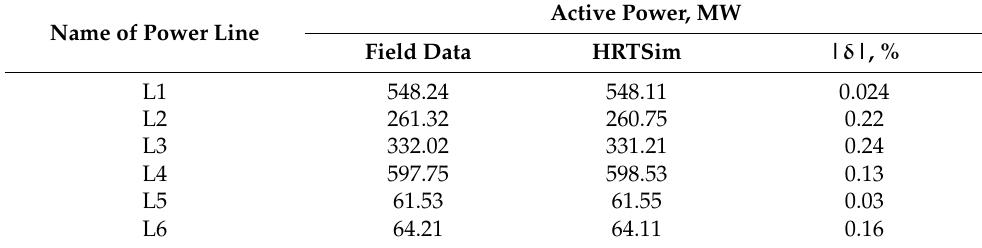
Table 3. Transmission Line Active